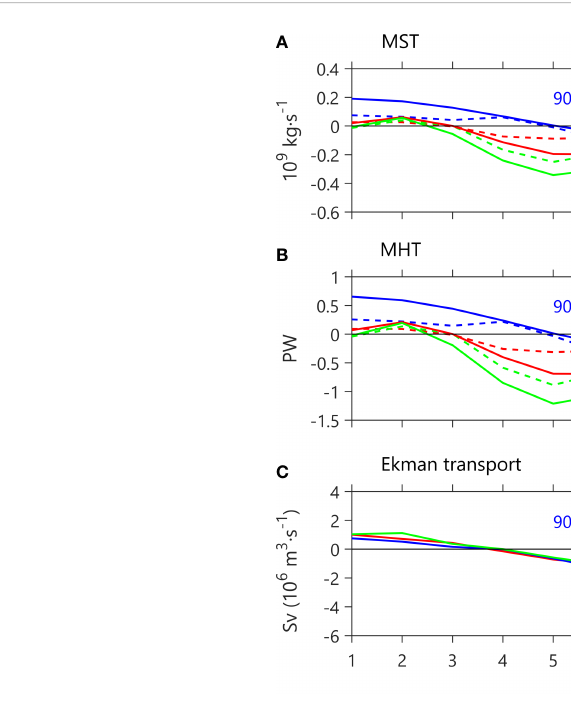
FIGURE 11 Zonally integrated (A) MST, (B) MHT, and (C) Ekman transports at 5°N, 0°, and 5°S, respectively, from the observations (solid lines) and the ECCO2 data (dashed lines). The western boundary of the integral is 90°E. Positive values are northward transports.